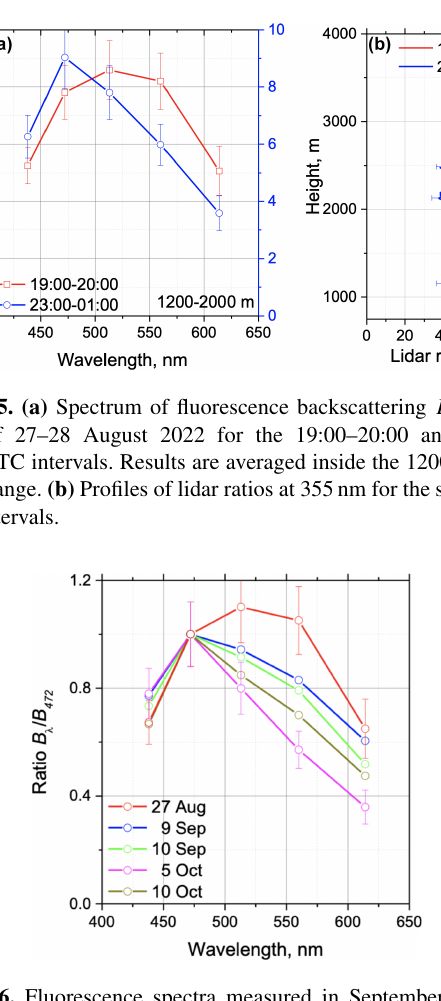
Figure 6. Fluorescence spectra measured in September–October 2022, when forest fires were over. Fluorescence-backscattering co- efficients B λ were averaged inside the 500–1000m height range and normalized according to B 472 . For comparison, the fluorescence spectrum in the smoke plume on 27 August from Fig. 5 is also pre-